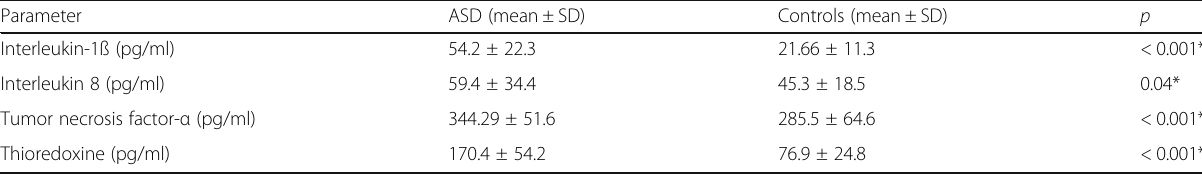
Table 3 Inflammatory cytokines and thioredoxin levels in the two studied groups Parameter